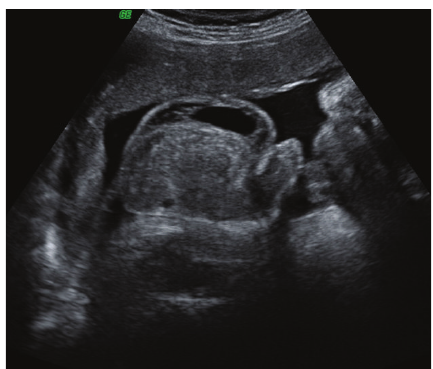
Figure 2: Hydrocele in the left scrotal side.